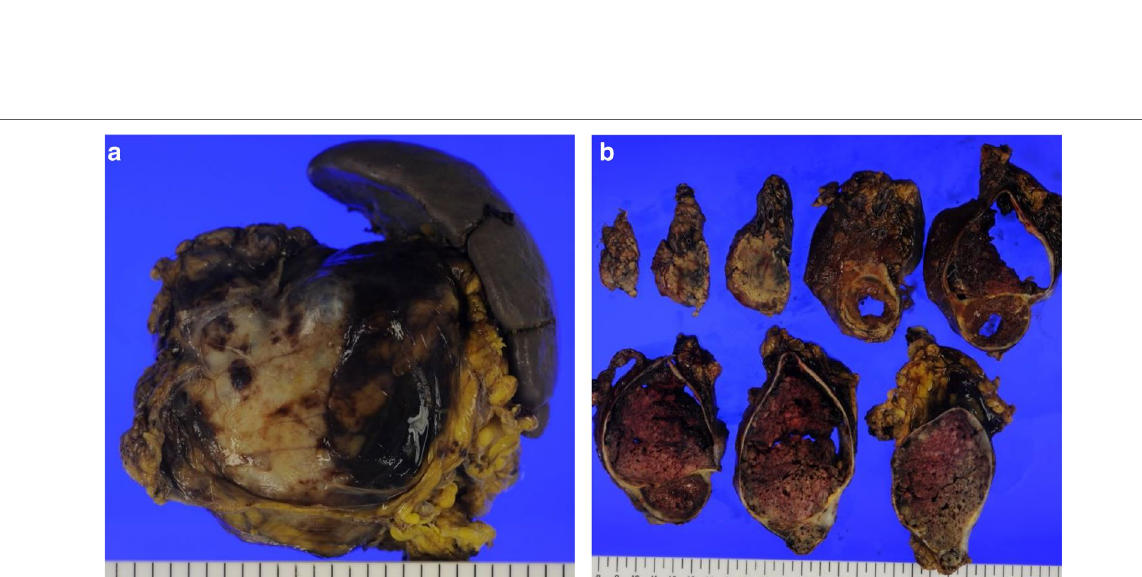
Fig. 4 Resected specimen. Gray solid component with bleeding and a multi-locular cystic component with necrosis were inside a thick capsule ( a , b )